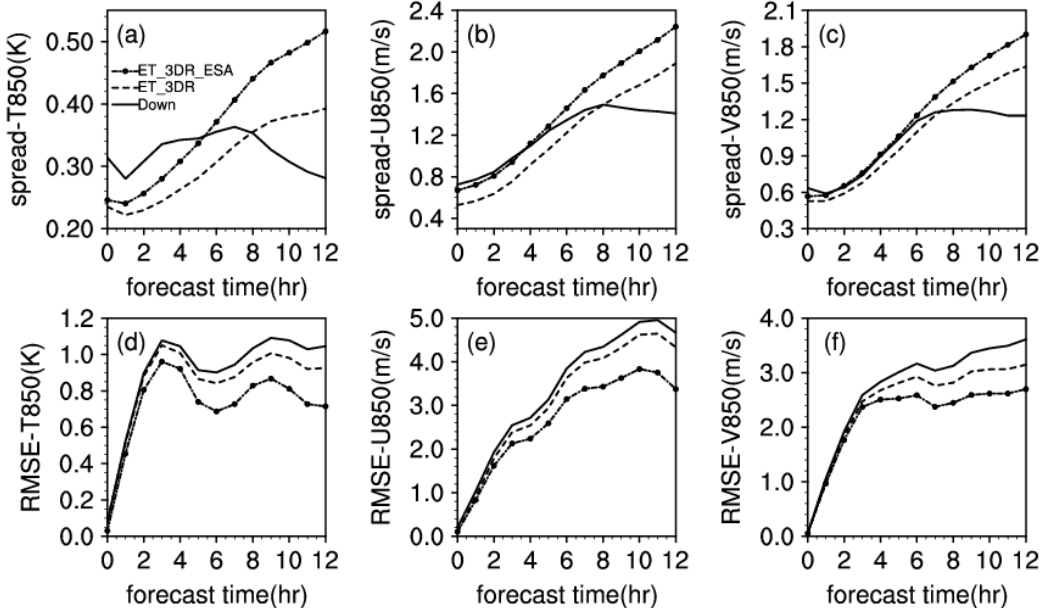
Figure 5. ( a – c ) Ensemble spread and ( d – f ) RMSE for the three ensemble forecast systems under 850-hPa conditions; ( a , d ) temperature T (unit: K), ( b , e ) zonal wind U (unit: m/s), and ( c , f ) radial wind V (unit: